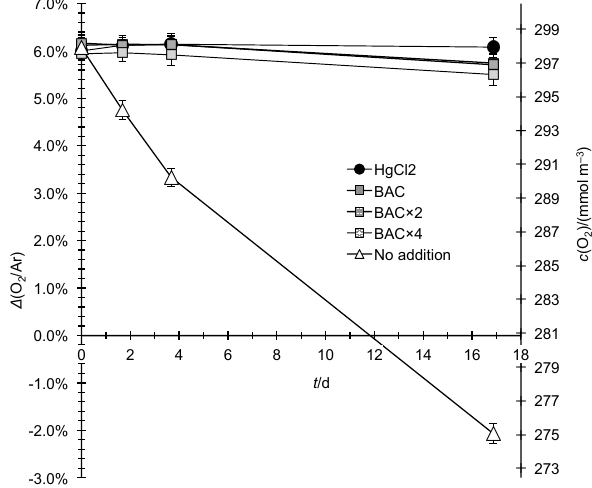
Figure 3. Biological oxygen supersaturation (cid:49) (O 2 / Ar) and corre- sponding oxygen concentration during TS3 (May 2010), for sam- ples without treatment (white triangle) and treated with BAC (grey square), BAC × 2 (dark grey stippled square), BAC × 4 (light grey stippled square) or HgCl 2 (black circle). Error bars include the day- to-day calibration